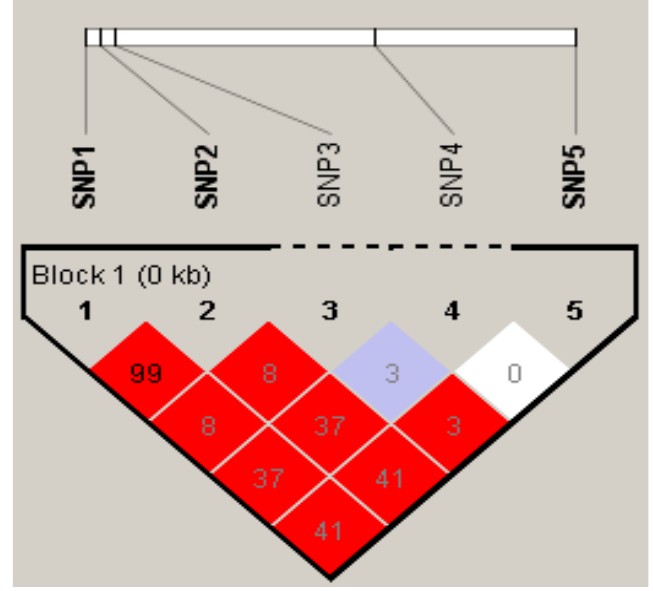
Figure 4. Different colors in the figure represent the degree of linkage between the loci. The color of the square gets darker with the degree of linkage from low to high. The number inside each square in the figure indicates the value of r 2 multiplied by 100.